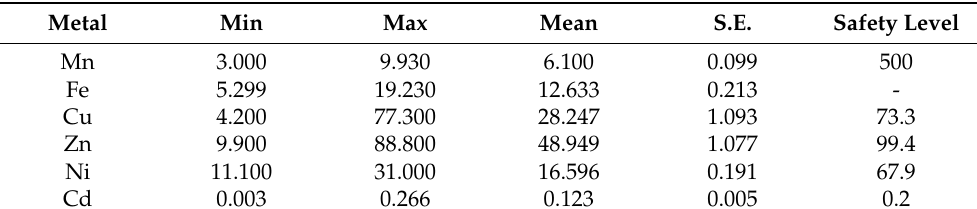
Table 1. Population performance for the measured metals. Minimum (min), maximum (max), and mean values in mg kg − 1 . S.E. represents standard error values. Accepted safety level threshold according to Al-Othman et al., 2016 [4].